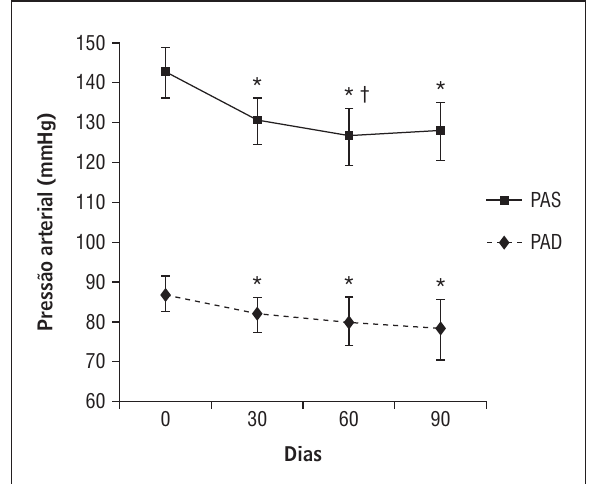
Figura 1 - Valores (média e desvio-padrão) da pressão arte- rial sistólica (PAS) e da pressão arterial diastó- lica (PAD), em milímetros de mercúrio (mmHg), durante repouso, nos períodos pré-treinamento (0), após 30, 60 e 90 dias de início de treinamento (n =